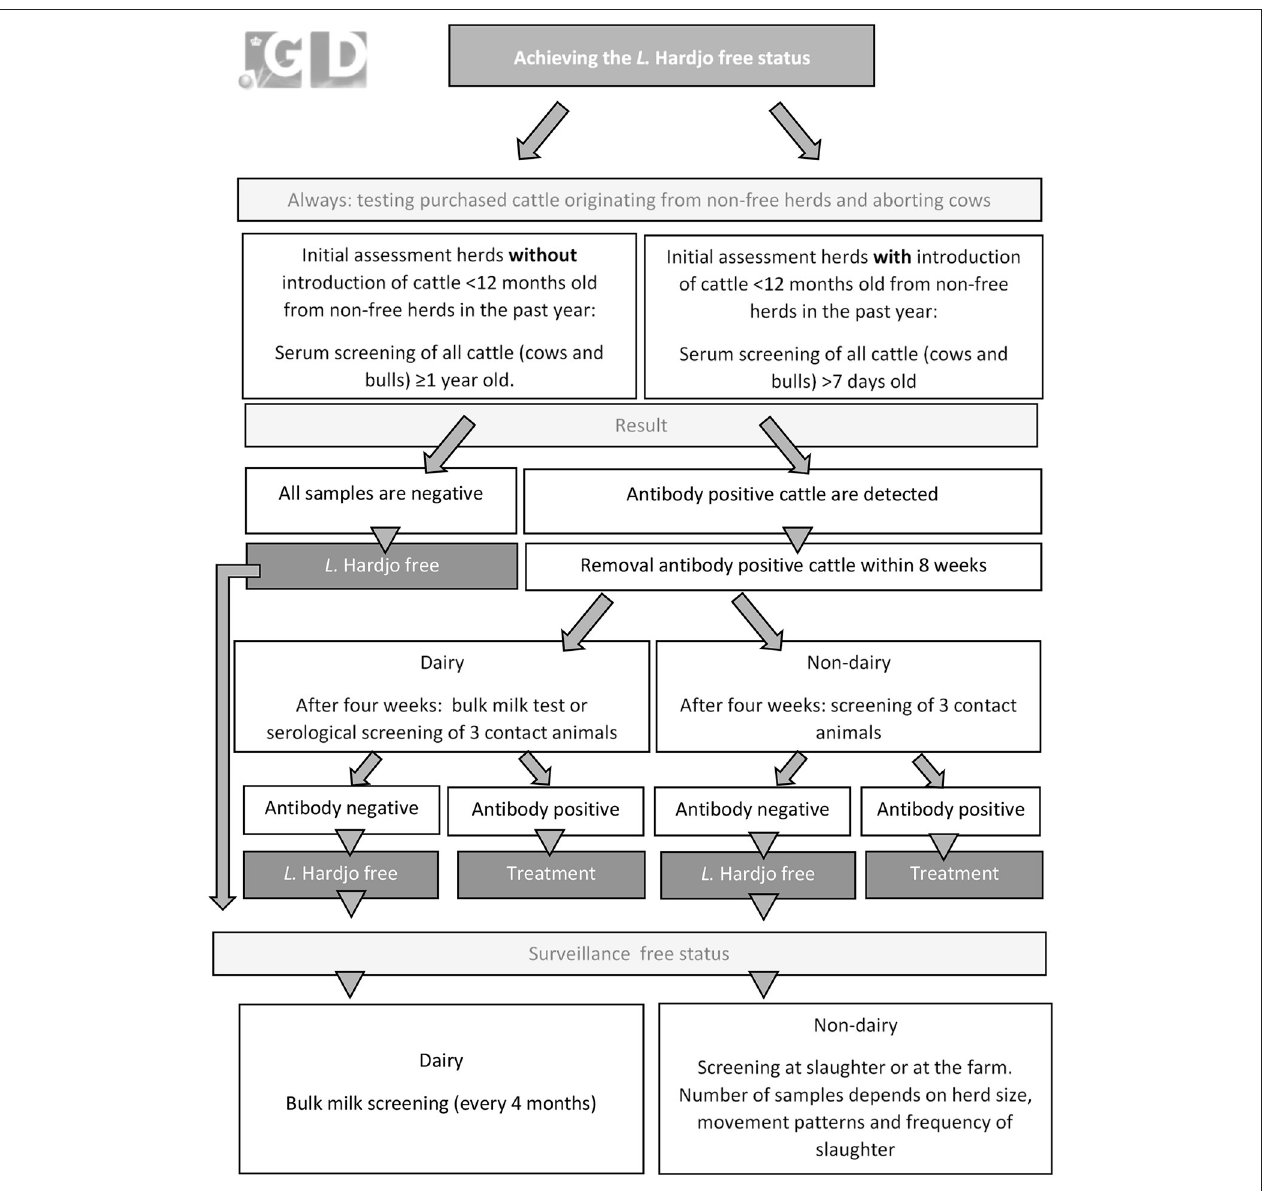
FIGURE 3 | Graphical overview of the L . Hardjo-control program in the Netherlands that was implemented in 1994.